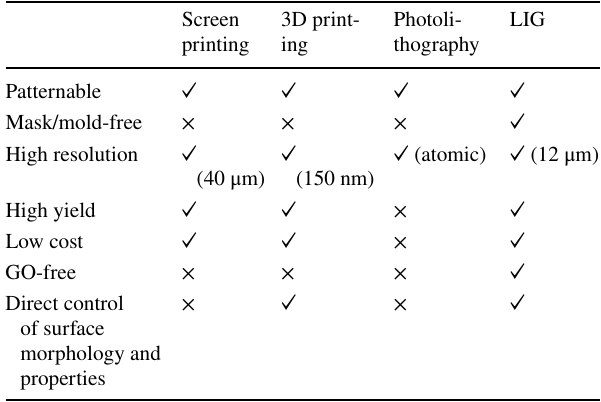
Table 1 Comparison of screen printing, 3D printing, photolithogra- phy, and LIG Screen